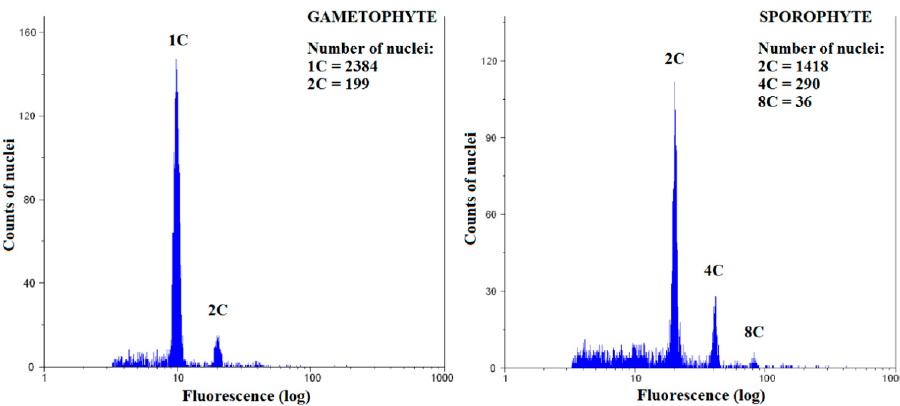
Figure 4. Representative flow cytometry histogram for Brachythecium rivulare gametophyte and spo- rophyte.